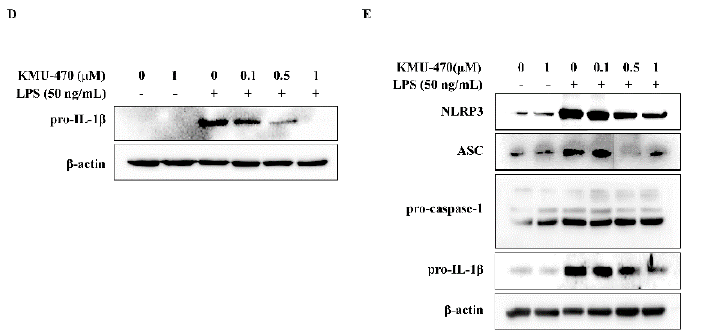
Figure 6. Inhibitory effect of KMU-470 on LPS-induced up-regulation of pro-inflammatory cytokines and activation of NLRP3 inflammasome in RAW 264.7 cells. ( A , B , C ) Cells were treated with KMU-470 for 30 min and stimulated with LPS 50 ng/mL for 6 h. The levels of IL-1β, TNF-α, and IL-6 were determined using real time PCR. *** p < 0.001, * p < 0.05. ( D ) Cells were pre-treated with 0.1, 0.5, and 1 μM of KMU-470 for 30 min and treated with LPS 50 ng/mL for 6 h, respectively. Whole cell lysates were isolated and used to measure the protein expression levels of pro-IL-1β and β-actin by Western blot analysis. ( E ) Cells were pre-treated with 0.1, 0.5, and 1 μM of KMU-470 for 30 min and treated with LPS 50 ng/mL for 6 h, respectively. Whole cell lysates were isolated and used to measure the protein expression levels of NLRP2, ASC, pro-caspase-1, pro-IL-1β , and β-actin by Western blot analysis.